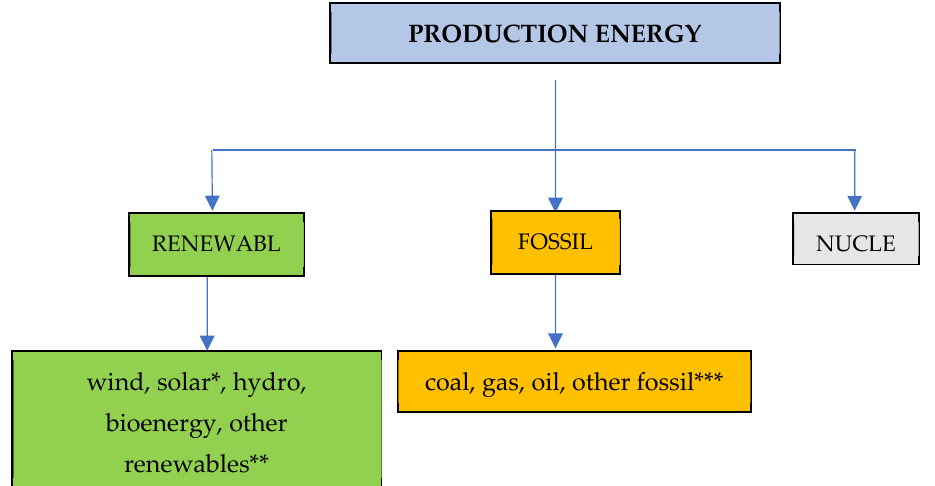
Figure 1. Structure of energy production. * The “solar” group includes all sources, including solar farms, photovoltaic cells and distributed generation. ** The “other renewables” group includes geothermal, tidal and wave power generation. *** The “other fossil” group includes sources that use raw materials: oil, petroleum products and industrial gases.